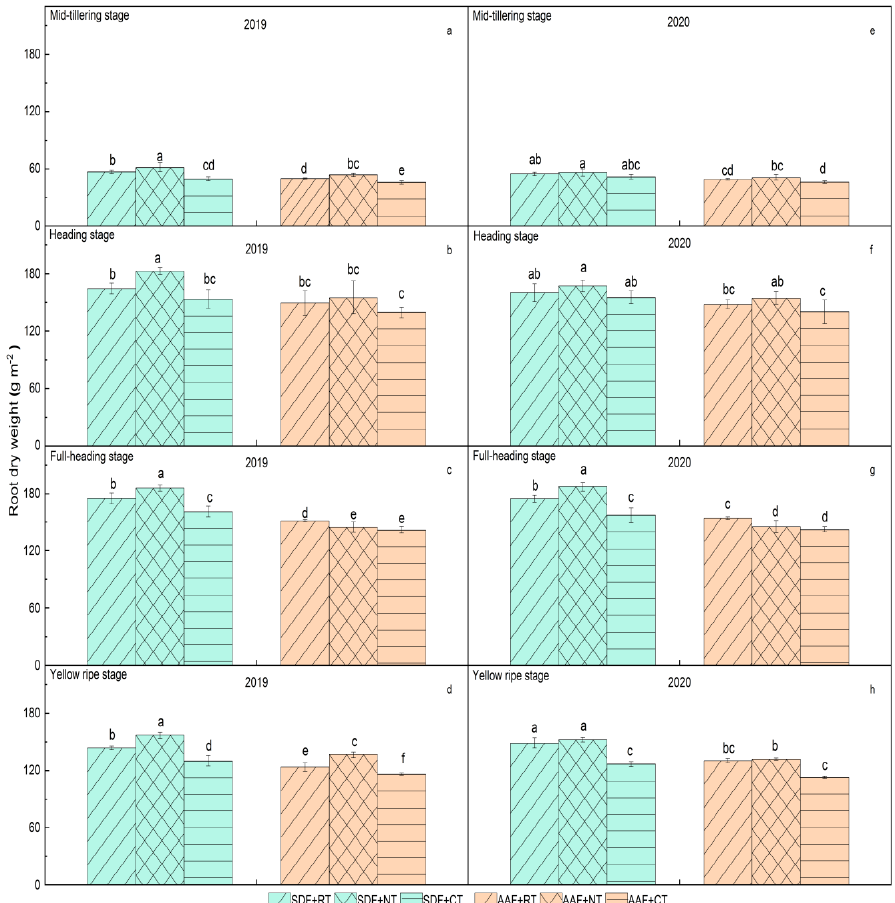
Figure 2. Root dry weight at different stages of rice under different tillage and fertilization treatments. ( a – d ) represent the root dry weight in mid-tillering stage, heading stage, and full-heading Scheme 2019, respectively. ( e – h ) represent the root dry weight in mid-tillering stage, heading stage, full-heading stage, and yellow ripe stage in 2020, respectively. Different lowercase letters marked on the histogram mean significant differences among treatments at the 5% level according to Duncan’s multiple-range test (0.05) (similarly hereinafter). 3.2. Leaf Area Index (LAI), Net Photosynthetic Rate (Pn), and Total Chlorophyll Content